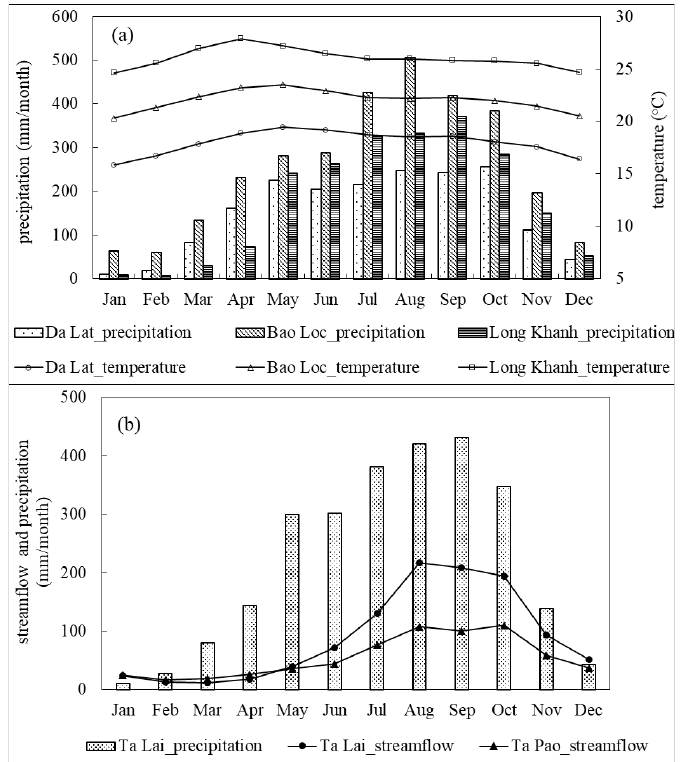
Figure 2. Mean monthly temperature and precipitation at different elevations in three stations Da Lat (>1000 m), Bao Loc (400~1000 m), and Long Khanh (<400 m) ( a ). Mean monthly streamflow compared to precipitation at Ta Lai and Ta Pao stations ( b ). (Precipitation data are not available at Ta Pao station).